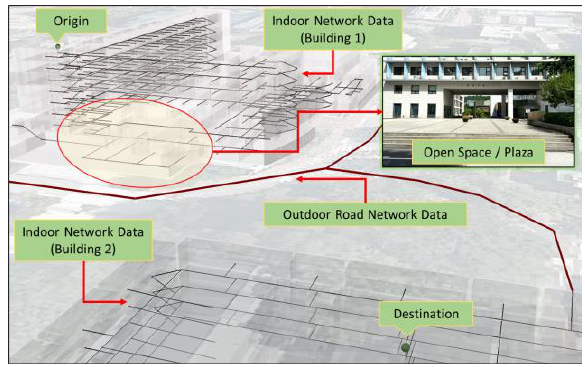
Figure 5 . Sample data for the implementation Based on the model of the SeamlessNavigation module in Figure implemented through the entrance of Building 1. As shown in Figure 6, the node representing this entrance is converted to an nodes are connected by a single edge to represent the AnchorLink.